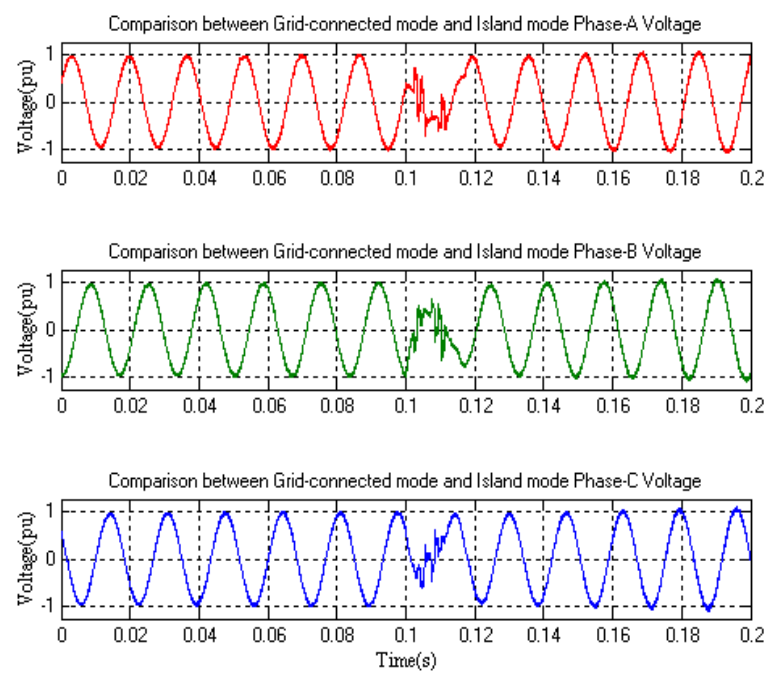
Figure 8. Phase A, B and C voltages of grid-connected mode and island